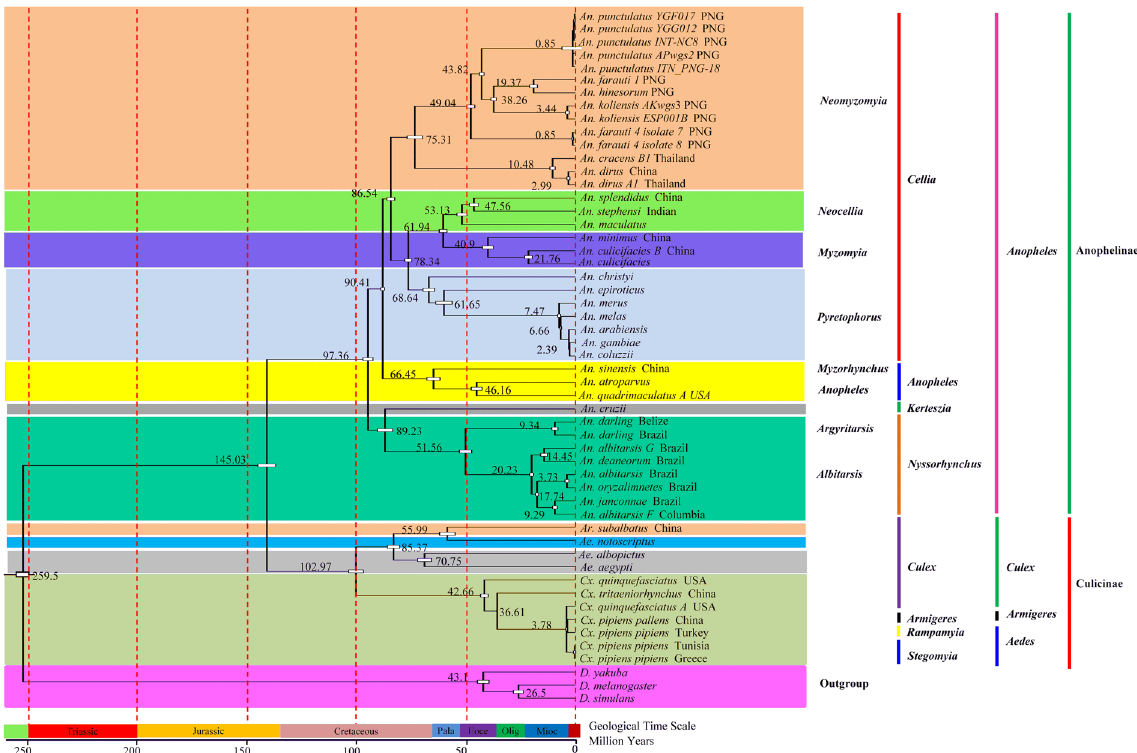
Figure 8. Evolutionary timescale for subfamily Anophelinae and Culicinae inferred from mtgenome PCG123 datasets based on BI tree. Numbers near the nodes indicate the average divergence time estimated (million years, Mya). In the geological time scale: Pala, Eoce, Olig and Mioc indicate Palaeocene, Eocene, Oligocene and Miocene,